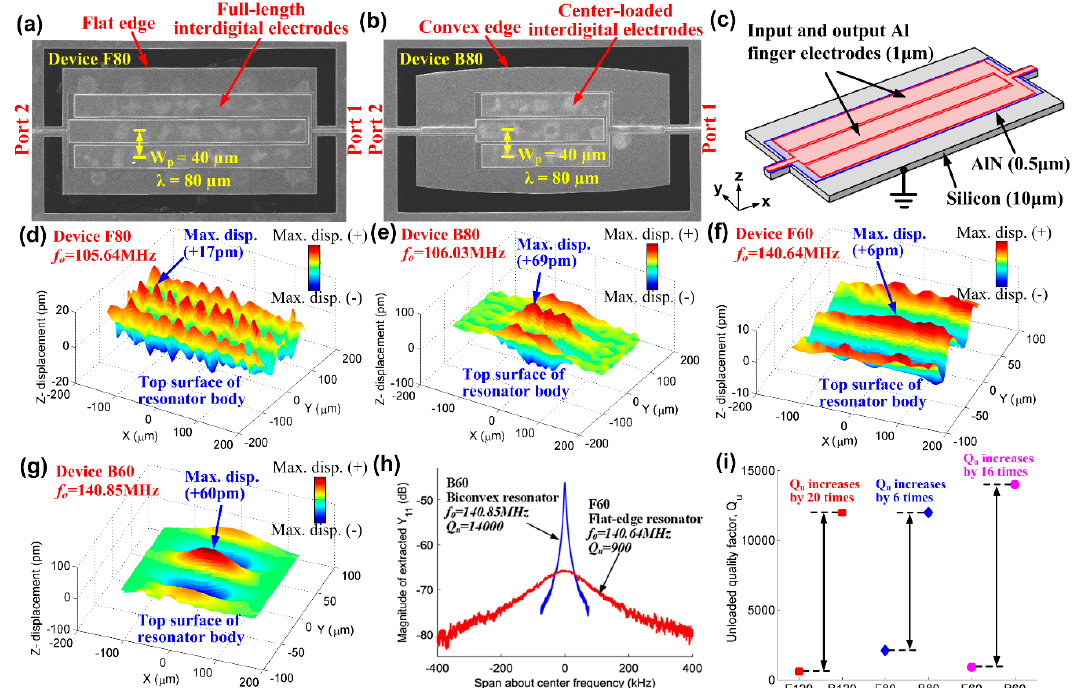
Figure 4. Experimental investigation of anchor loss using laser Doppler vibrometry: ( a ) scanning electronmicrograph(SEM)ofaflat-edgeAlN-on-Siresonator; ( b )SEMofabiconvexAlN-on-Siresonator; ( c ) schematic of a typical structure for AlN-on-Si LVR; ( d – g ) measured z-direction displacement profile on the top surface of four resonators (F80 / B80 denotes flat-edge / biconvex resonator with acoustic wavelength of 80 µ m); ( h ) measured magnitude of admittance frequency response for flat-edge resonator (F60) and biconvex resonator (B60), showing much higher Q of the latter; ( i ) comparison of measured Qs among three groups of device with di ff erent resonant frequencies (each group includes a